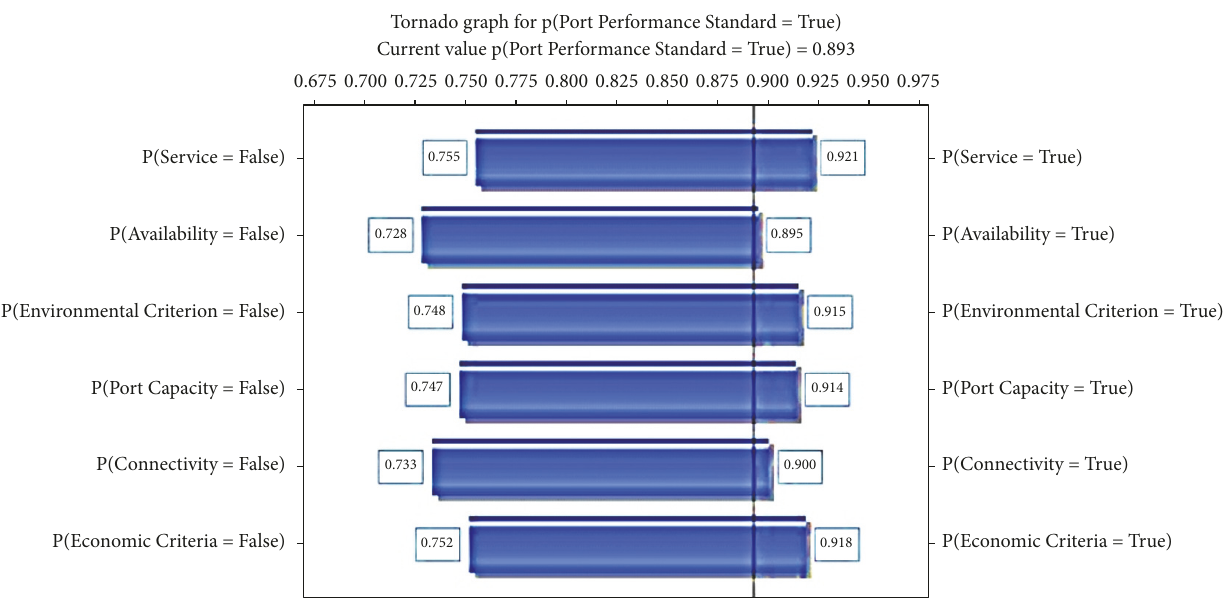
Figure 4: Sensitivity analysis of